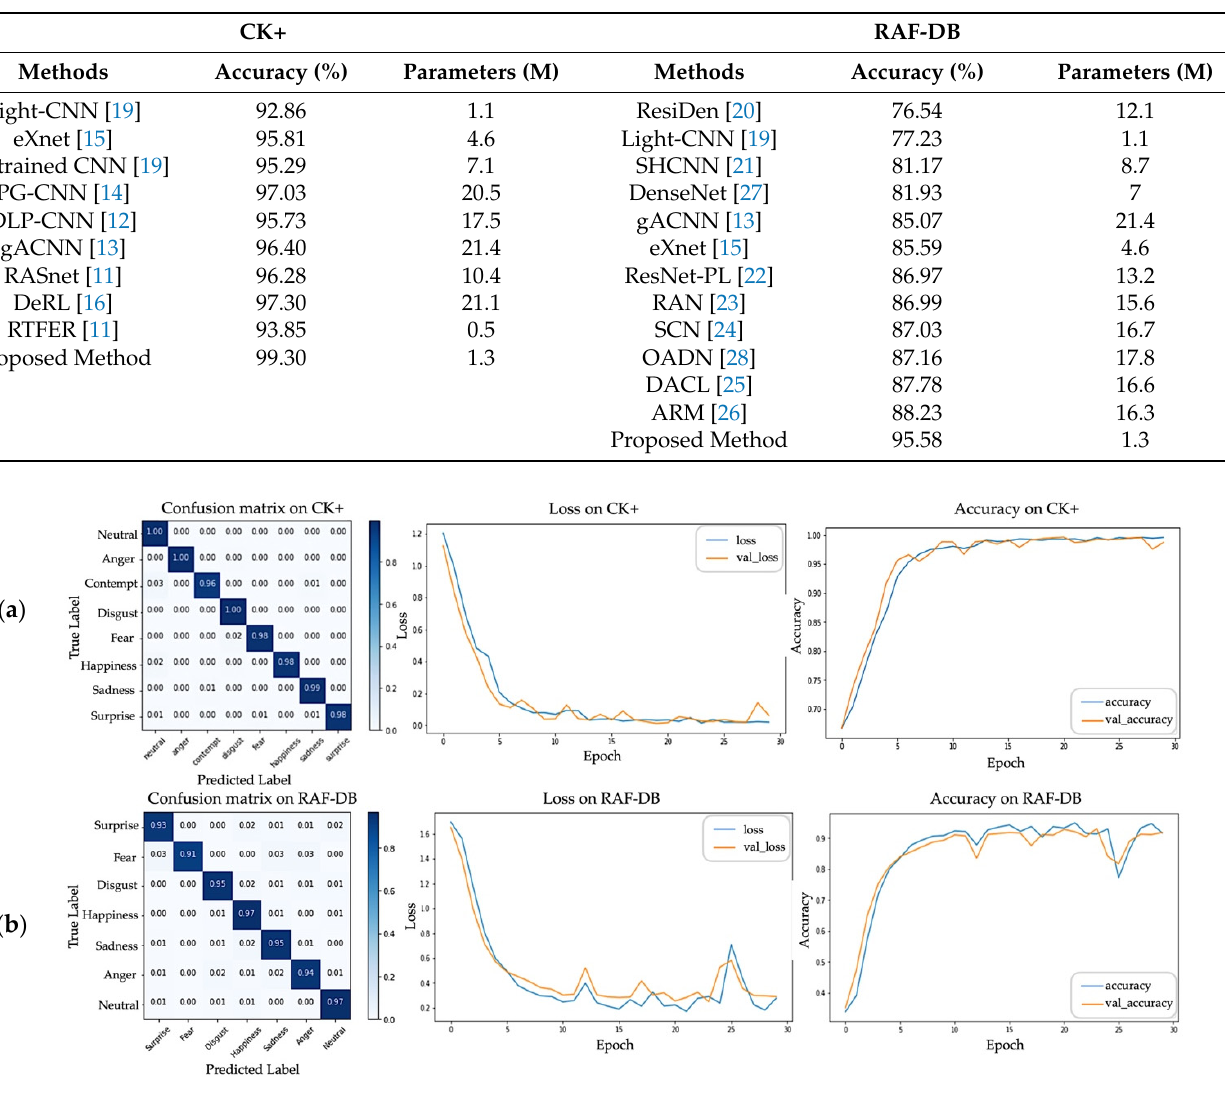
Table 2. State-of-the-art results of the CK+ and RAF-DB data sets.